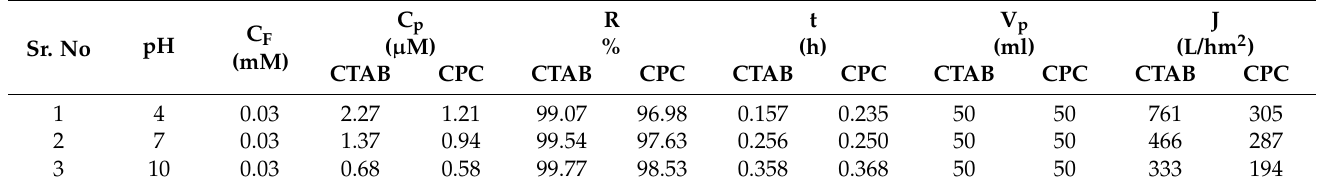
Table 7. Rejection coefficient, R%, and permeate flux, J, of Naphthol Green B for different values of pH, at fixed dye concentration, C F , dye concentration in permeate solution, C p , filtration time, t, permeate volume, V p